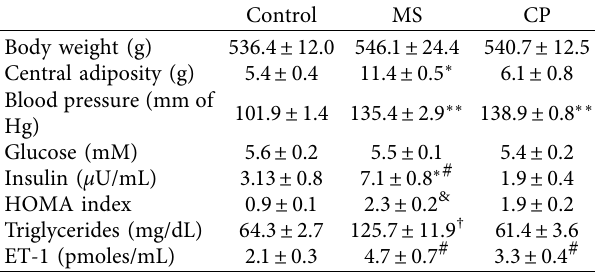
Values are mean ± SEM n � 8, ∗ P < 0 . 01 MS versus C and CP; ∗∗ P < 0 . 001 MS and CP versus C; # P < 0 . 05 MS and CP versus C; † P < 0 . 01 MS versus C and CP; & P < 0 . 05 MS versus C and